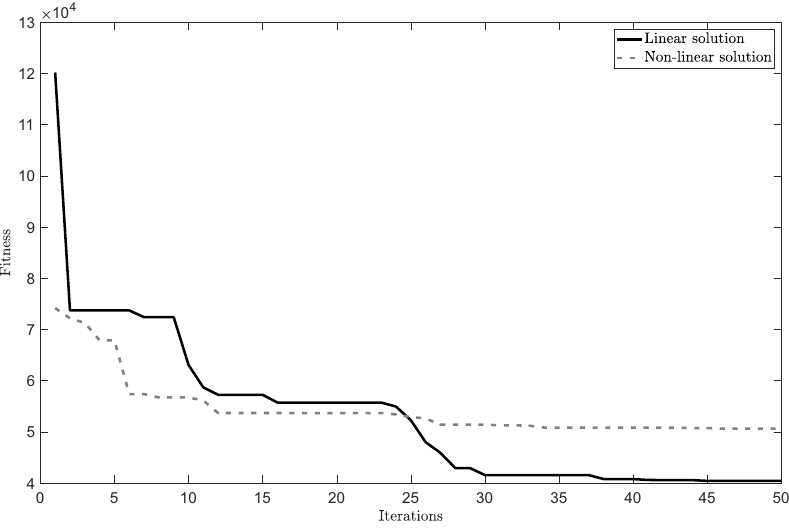
Figure 7. Fitness evolution in the CRO-SL for the submerged arch design case in which the height H is fixed.